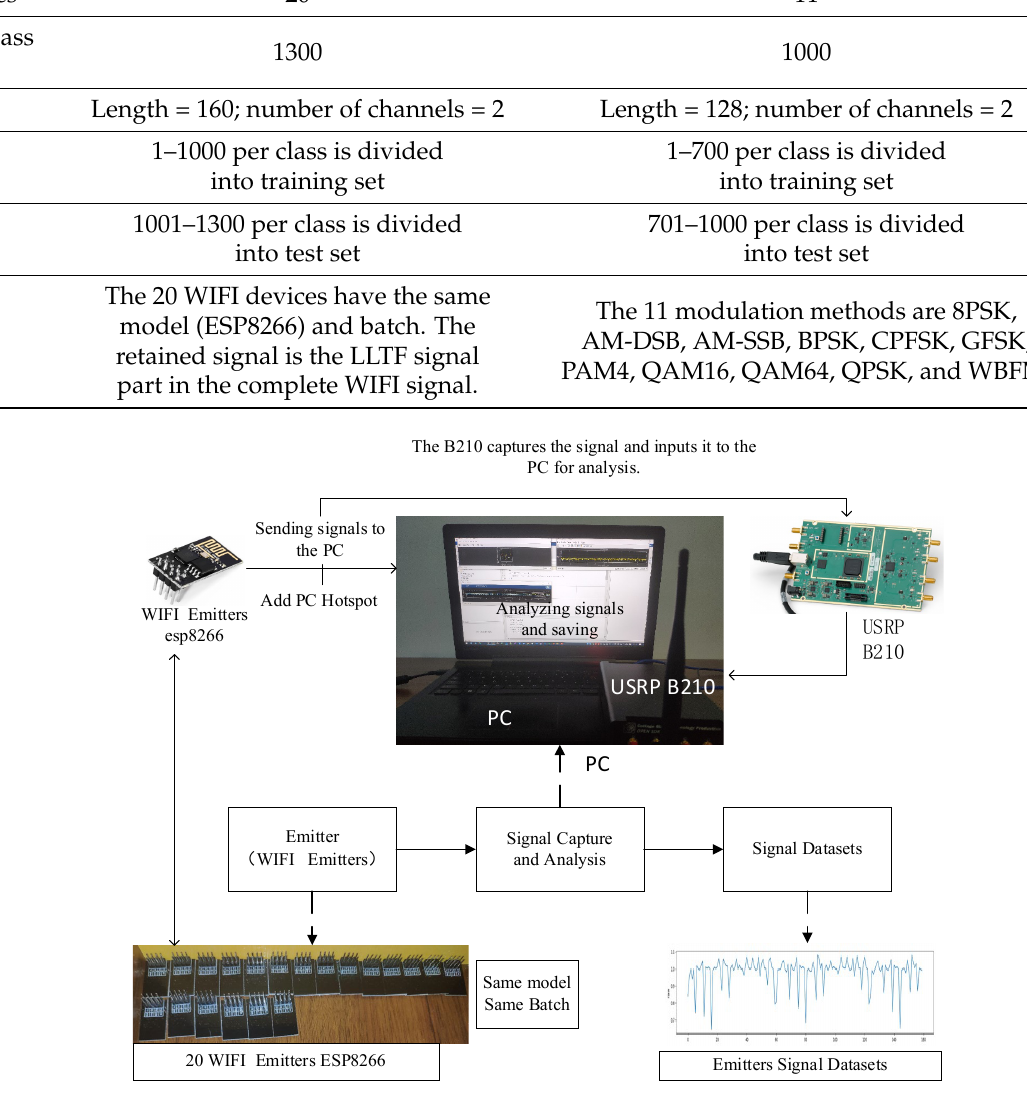
Figure 3. The production process of WIFI emitter communication platform and signal